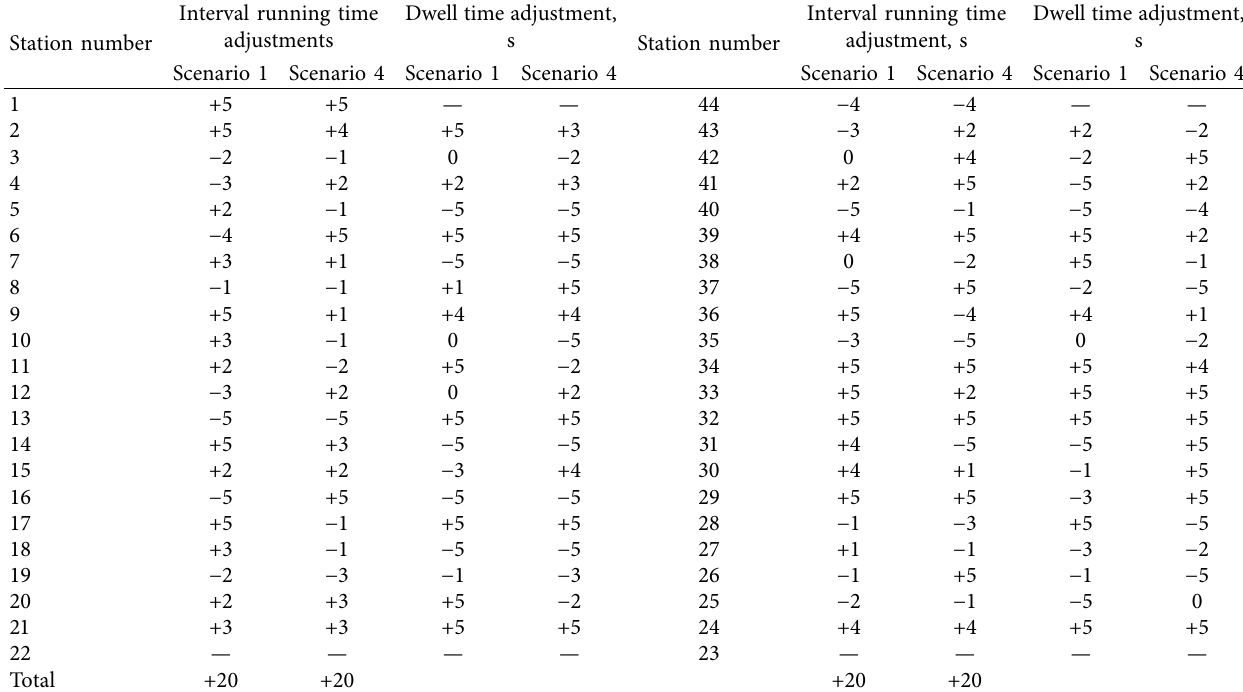
Table 5: Comparison of optimization schemes between Scenario 1 and Scenario